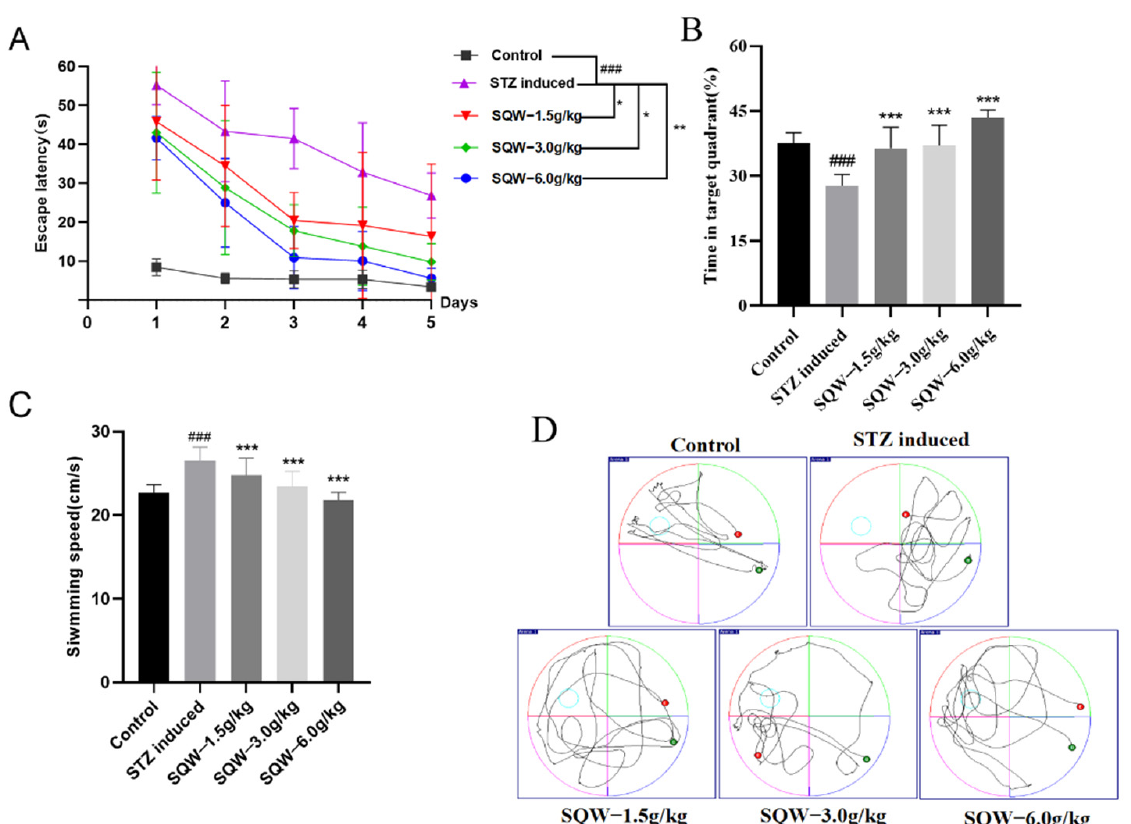
Figure 2. SQW improves STZ-induced learning and memory impairment in rats ( n = 7). ( A ) The results of escape latency in five groups. ( B ) The proportion of time in the platform quadrant. ( C ) Average swimming speed. All of the results are expressed as means ± SD, n = 7 per group. Compared with the control group, ### p < 0.001; compared with the STZ induced group, * p < 0.05, ** p < 0.01, *** p < 0.001. ( D ) Swimming trajectory